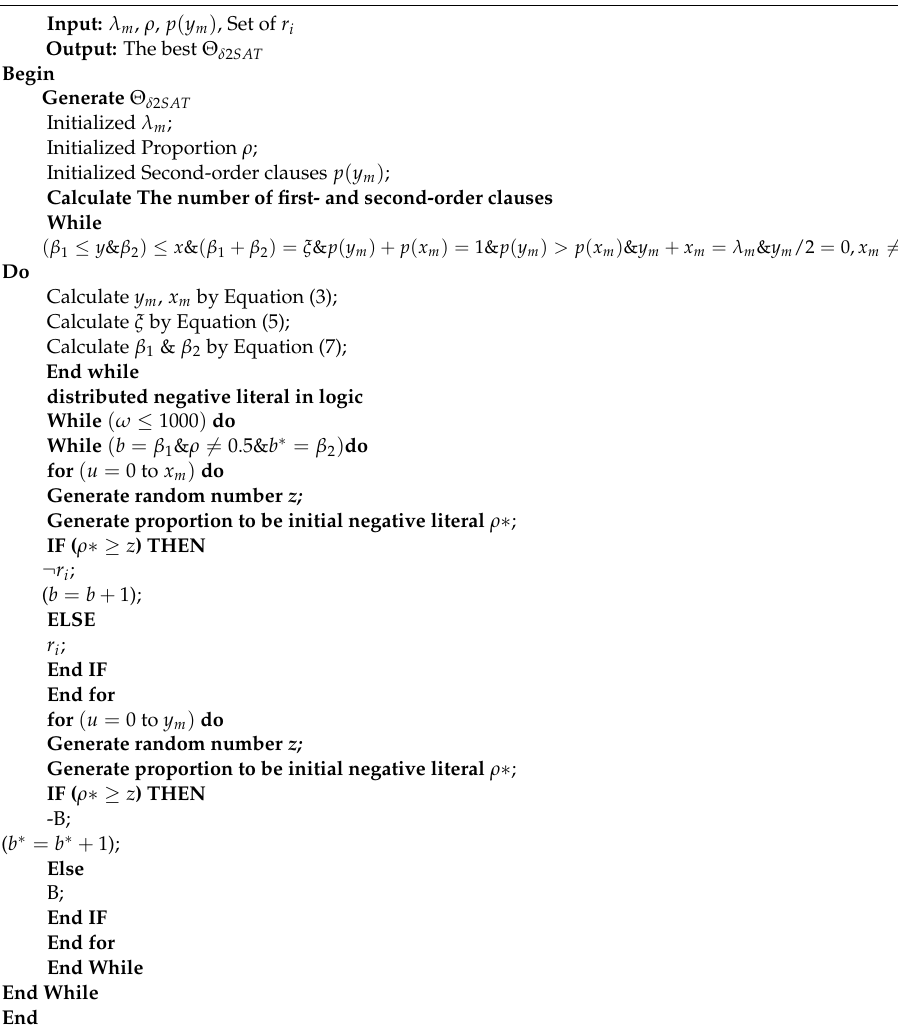
Algorithm 1: Pseudocode for generating the probability of logic